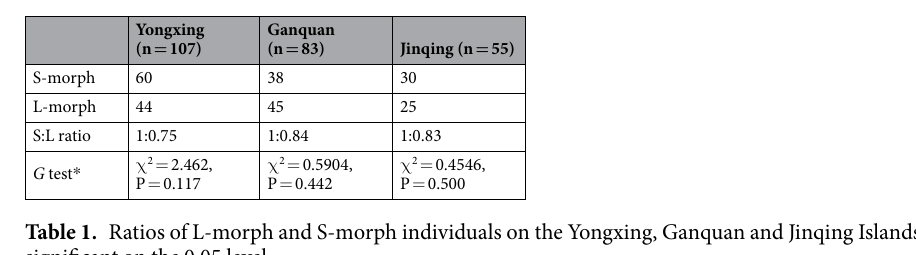
Table 1. Ratios of L-morph and S-morph individuals on the Yongxing, Ganquan and Jinqing Islands. * Not significant on the 0.05